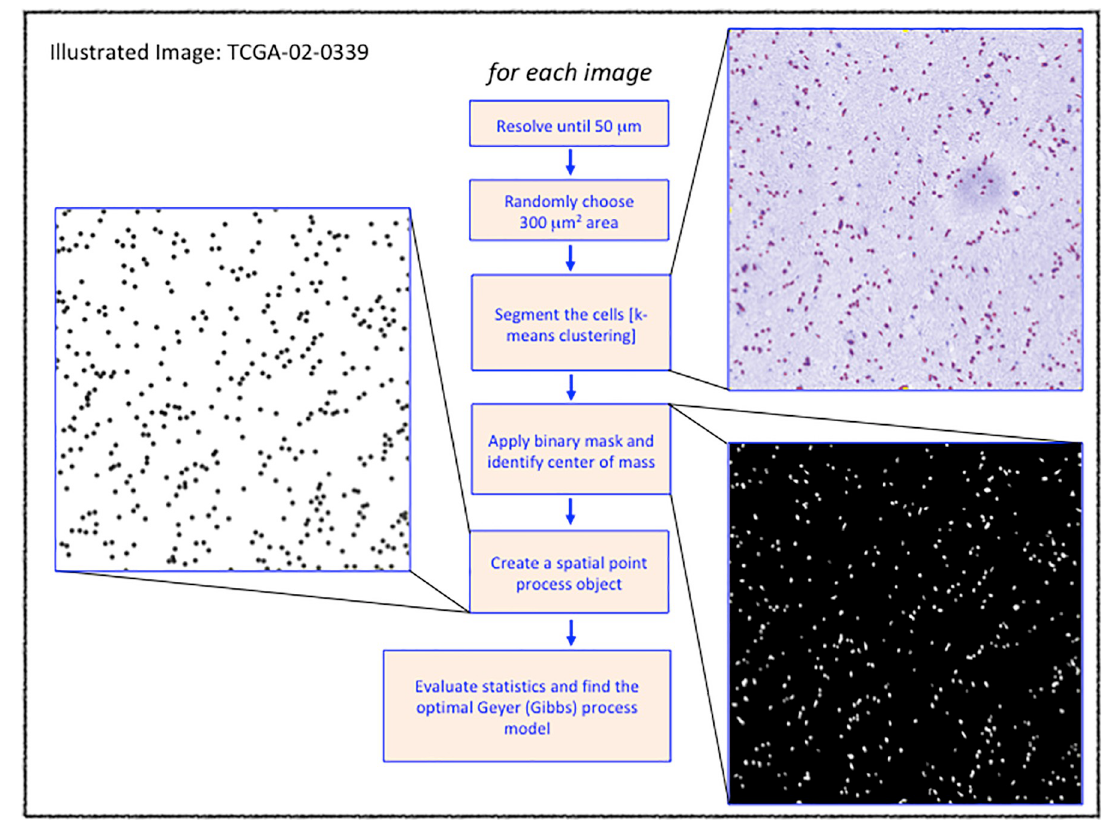
Fig 1. Image processing